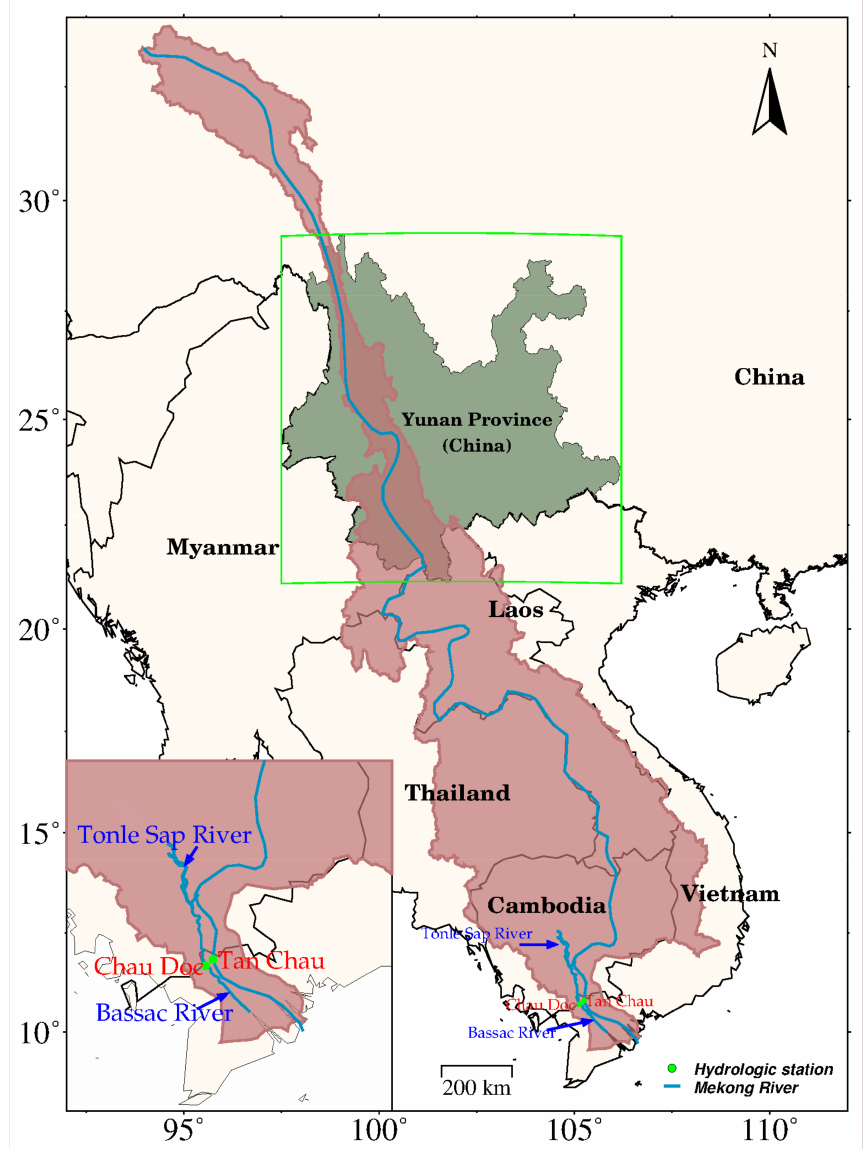
Figure 1. The Mekong River Basin (red area) overlapping with Yunnan province of China (dark green area) covered with the hydrologic stations at the river delta entrance (green